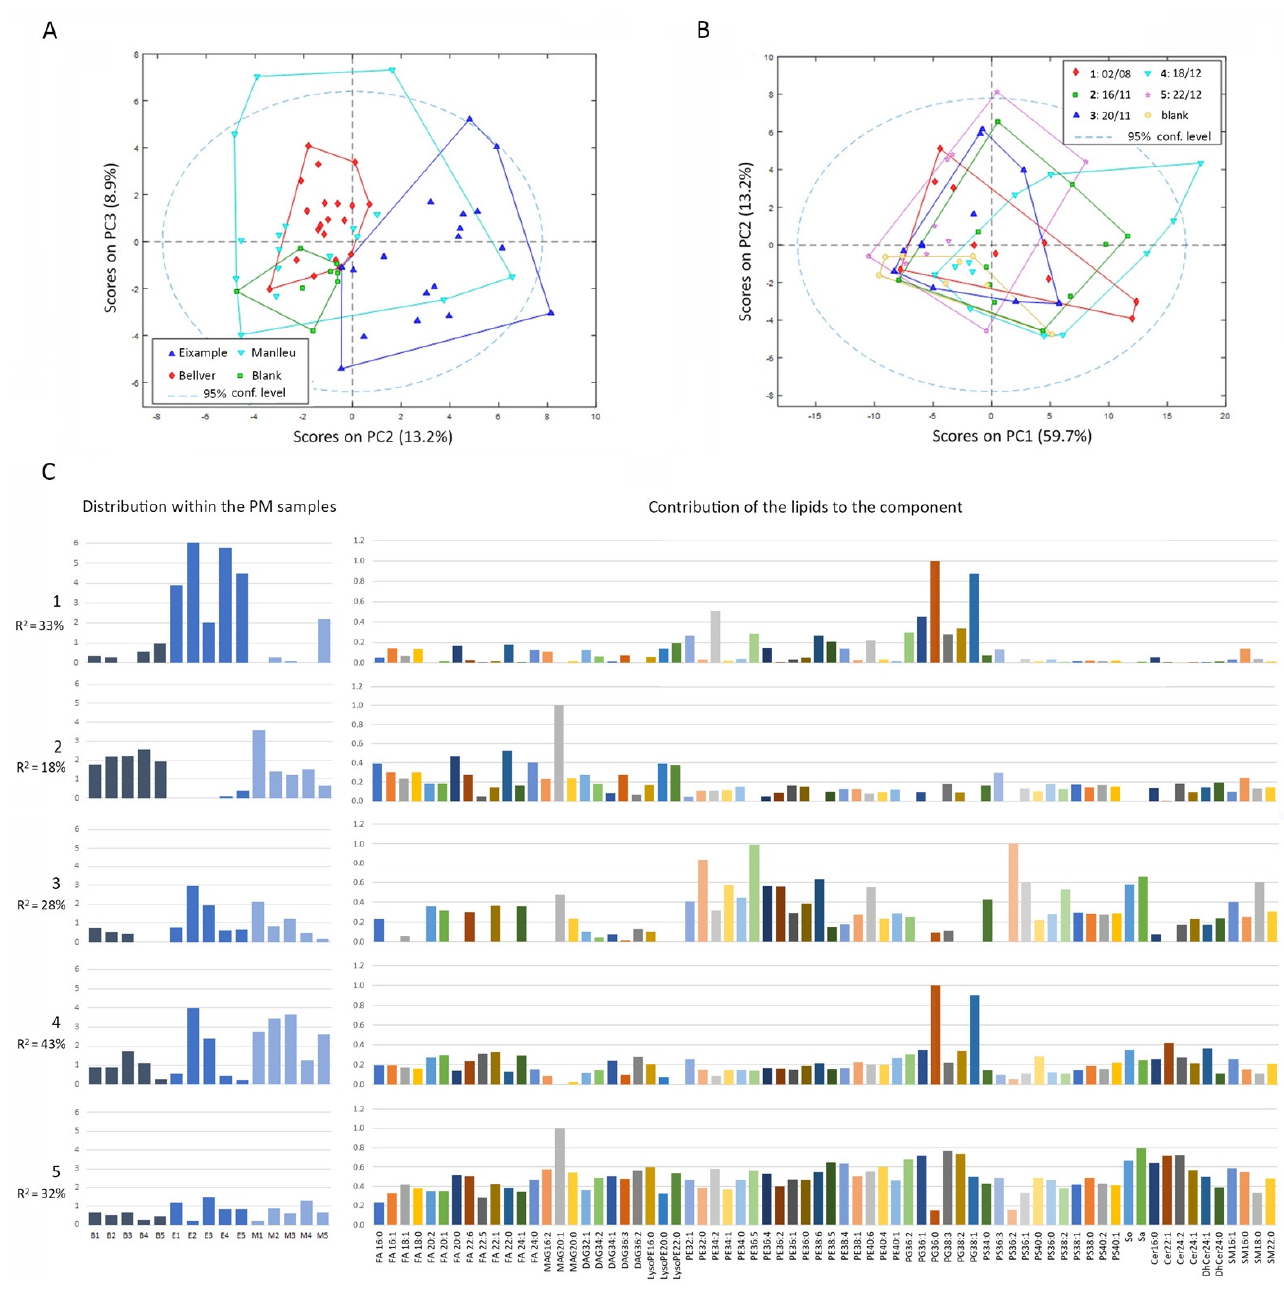
Figure 3. Lipidomics analysis of lung cancer cells exposed to PM 10 filter extracts. PCA analysis of lipid areas matrix considering ( A ) different locations or ( B ) different collection dates. ( C ) MCR-ALS resolved components from lipidomics data. For each component, the left bar plot represents the sample contribution to the component. The right bar plot indicates the lipid chemical profile of each resolved component. Different color bars in these plots are only meant to facilitate the vertical cor- respondence to the x -axis in all the plots. FA: fatty acid; MAG: monoacylglycerol; DAG: diacylglyc- erol; PE: phosphatidylethanolamine; PG: phosphatidylglycerol; PS: phosphatidylserine; So: sphin- gosine; Sa: sphinganine (dihydrosphingosine); Cer: ceramide; DhCer: dihydroceramide; SM: sphin- gomyelin.